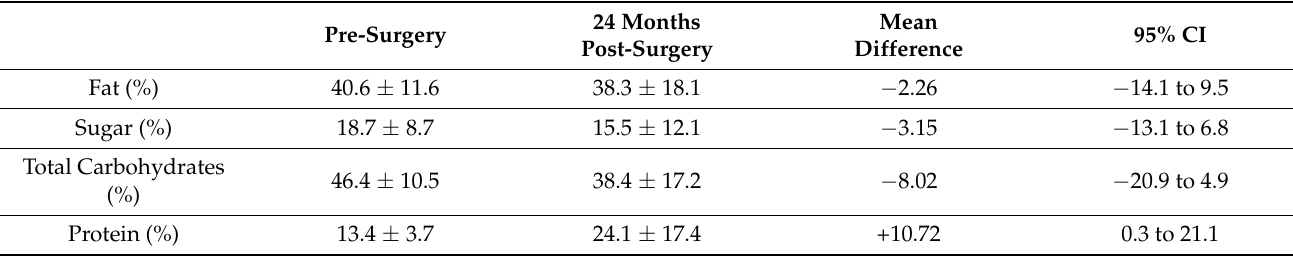
Table 4. Percentage contribution of individual macronutrients to energy intake at buffet meal Data presented as mean ± standard deviation. 24 Months Pre-Surgery